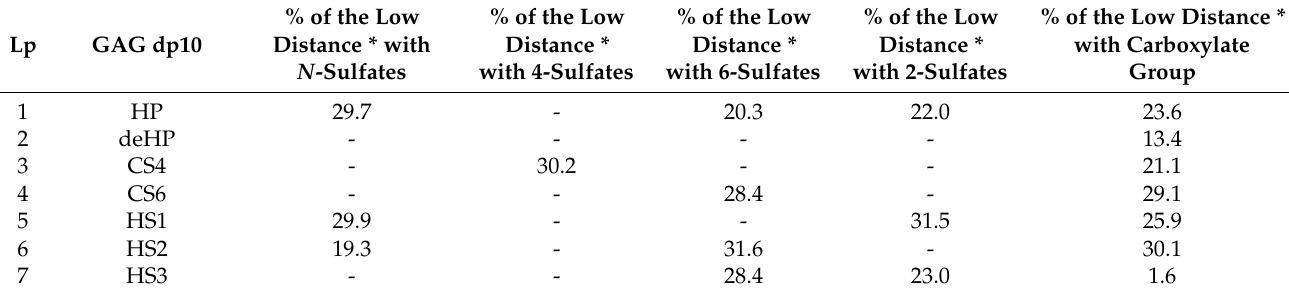
Table 3. Distance analysis for interactions between MB and GAGs expressed in terms of the MD simulation time